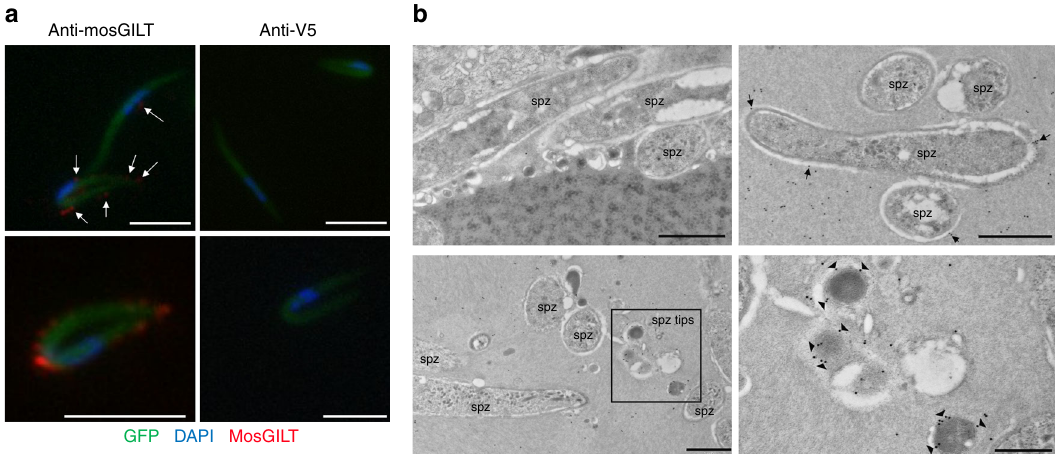
Fig. 3 MosGILT binds to the surface of P. berghei sporozoites. a Immunostaining with a mosGILT speci fi c monoclonal antibody revealed endogenous SG mosGILT bound to the surface of P. berghei sporozoites. An irrelevant mouse monoclonal, anti-V5, was used as a control. All images are representative of more than three independent experiments. MosGILT bound to sporozoites is highlighted by white arrows (Scale - 5 μ m). b Immunoelectron microscopy labeling of endogenous mosGILT on P. berghei sporozoites within intact SGs. Sporozoites labeled with a control mouse serum (top left). Sporozoites labeled with the anti-mosGILT monoclonal antibody, top right and bottom panels. The region highlighted by a black square represents a higher magni fi cation of predicted sporozoite anterior or posterior tips, bottom right. Arrows highlight mosGILT labeling at the surface of sporozoites (spz-sporozoite; scale 1 μ m and 500 nm bottom